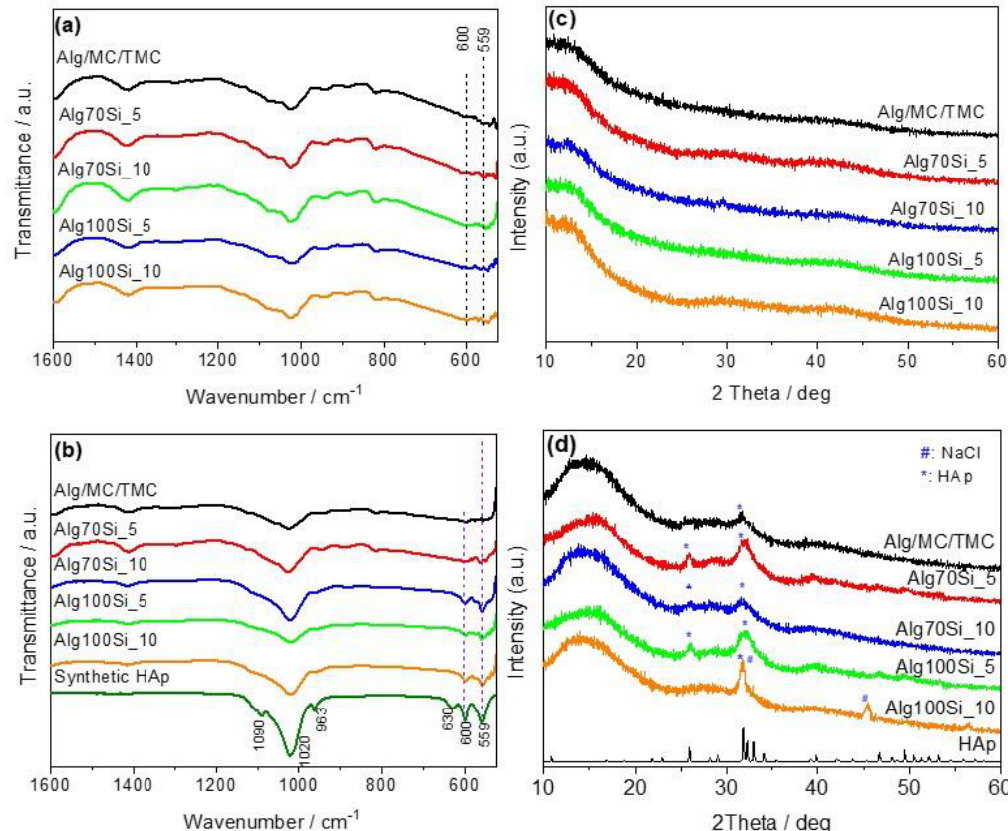
Figure 5. FTIR and XRD graphs of samples before ( a , c ) and after ( b , d ) immersion in 2xSBF solution for 2 weeks. The FTIR spectrum of synthetic HAp and standard JCPDS card No 9-432 of HAp are also shown for comparison.